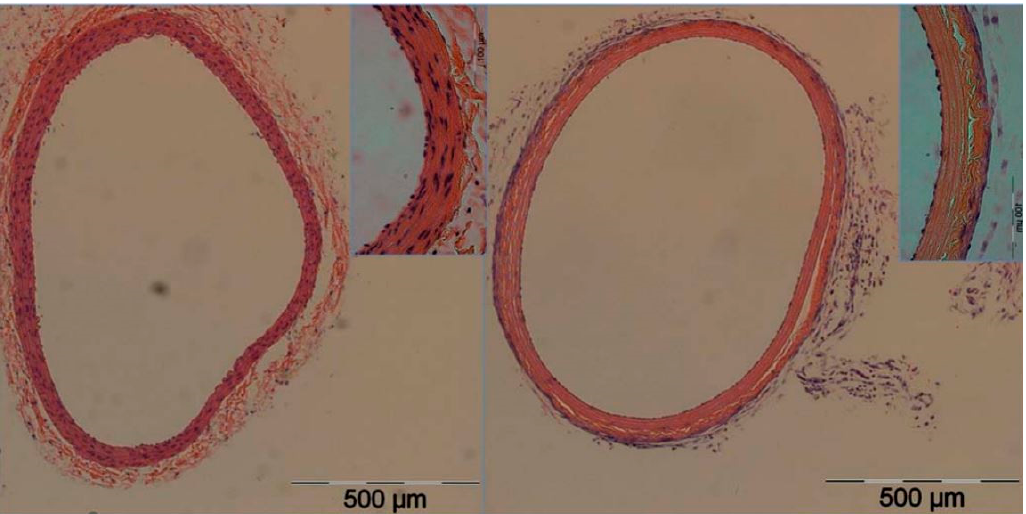
Figure 3. Total IRE-mediated ablation of vascular smooth muscle cells in rats. Cross-sectional image of rat carotid artery (right) after IRE-mediated total vascular smooth muscle ablation. Note the absence of vascular smooth muscle cells and repopulation of endothelial layer. The contralateral untreated carotid artery (left) was used as a control and demonstrates the abundance of vascular smooth muscle cells. Reproduced from with permission Maor, E. et al., PLoS ONE ; published by Plos One, 2009.